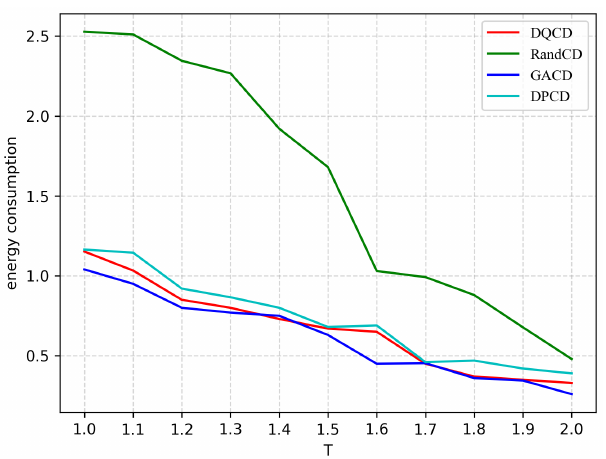
Figure 4. Comparison of energy